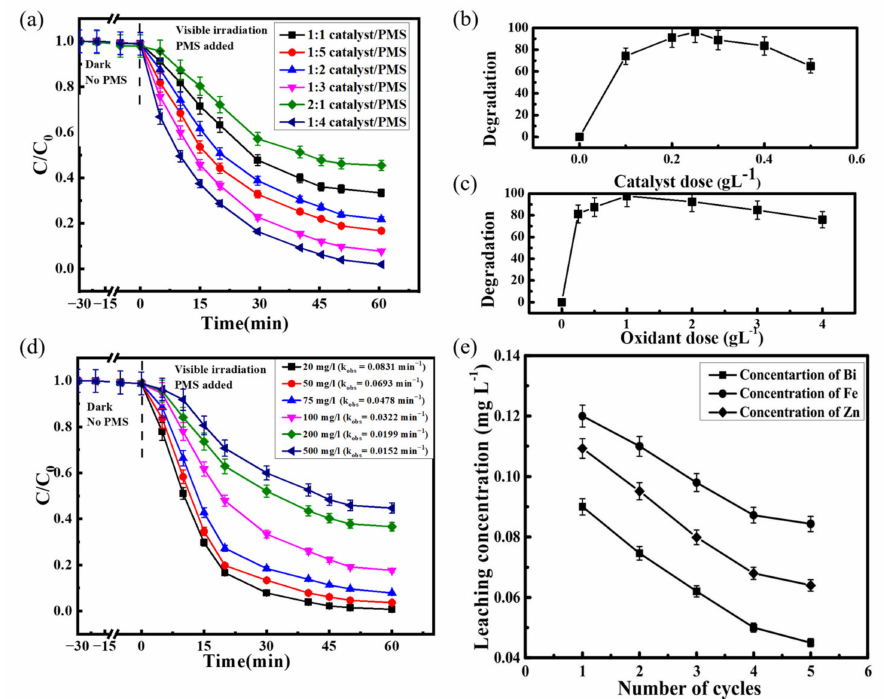
Figure 7. ( a ) The TCP degradation using different g-C 3 N 4 /ZnFe 2 O 4 /Bi 2 S 3 catalysts: PMS dosage; ( b ) determination of the optimum catalyst dosage; ( c ) determination of the optimum PMS